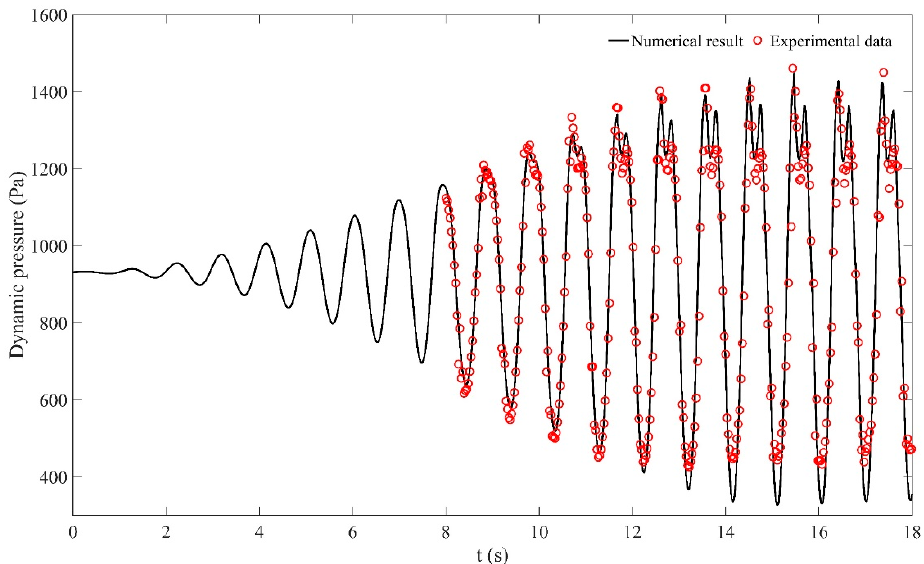
Figure 4. Comparison of time histories of the dynamic pressures between the present numerical result (solid line) and experimental data (circle) at P1.